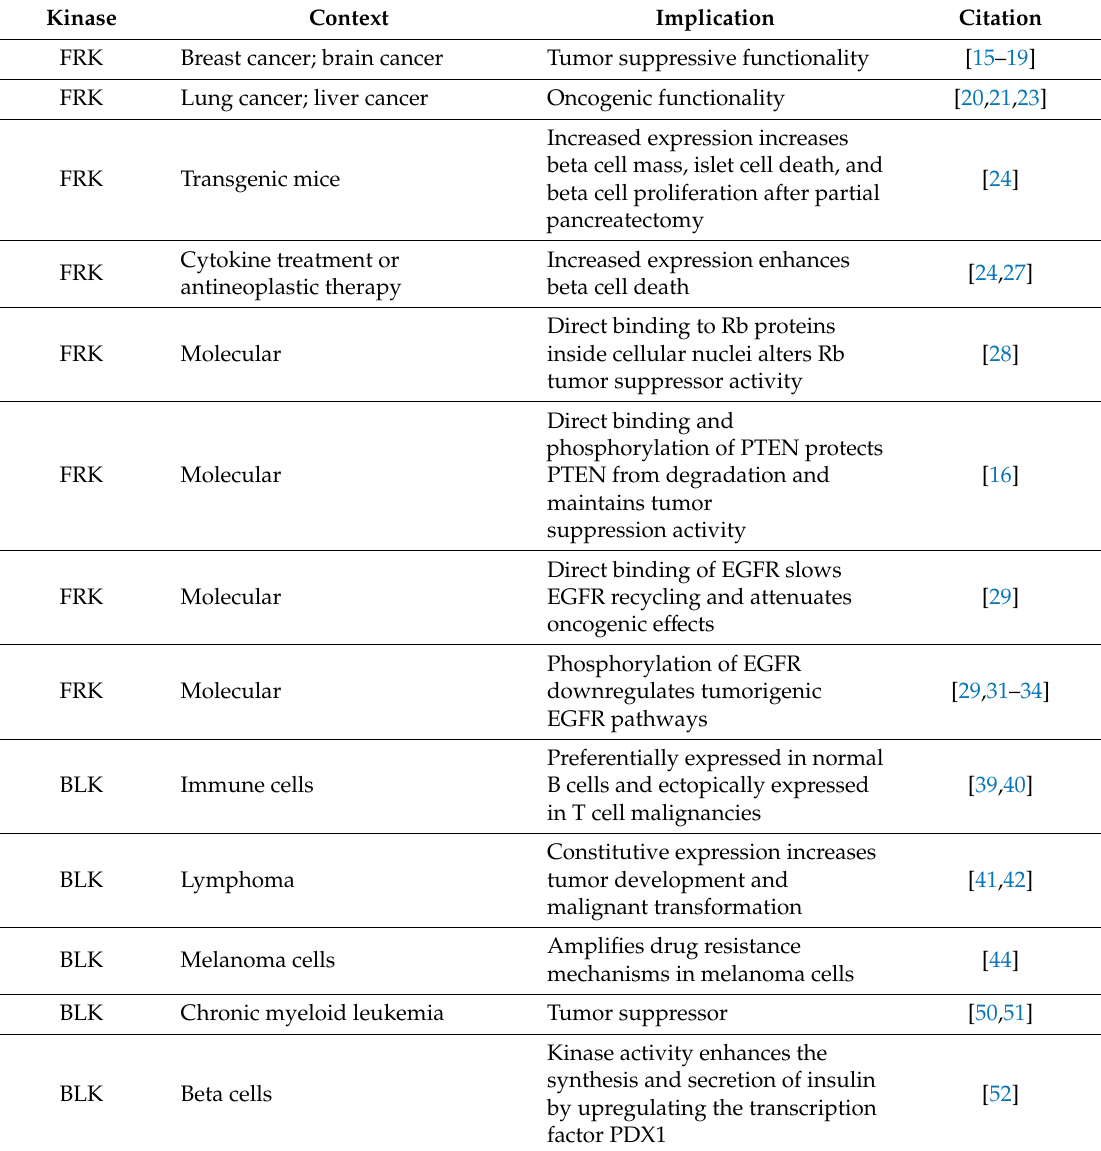
Table 2. Summary table of selected kinases in other